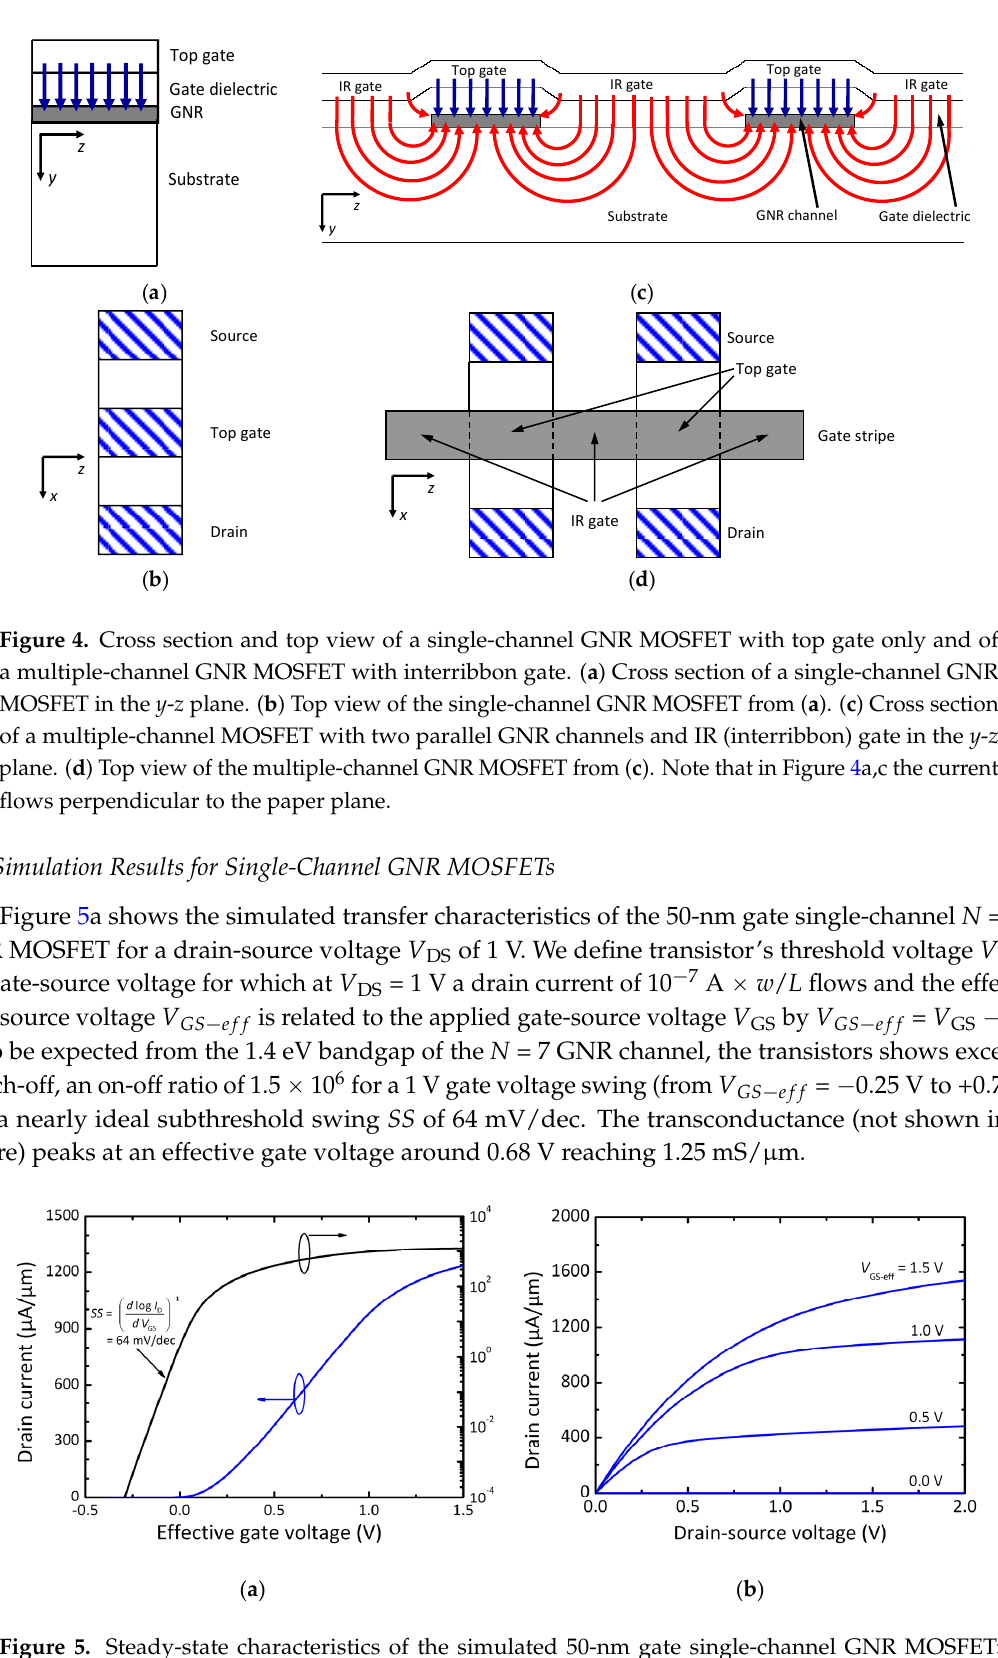
7 of 17 Figure 3. Cross-section (in the x - y plane) of the simulated graphene nanoribbon MOSFET. 3.1. Simulated Transistor Structures The basic structure of our simulated GNR MOSFETs is shown in Figure 3 in a cross-sectional view. The current flows in the x direction, the width of the GNR extends into the z direction (not shown), and the thicknesses of the substrate, the GNR channel, and the gate dielectric extend into the y direction. The structure consists of a semi-insulating SiC substrate, of which the upper part with a thickness of 1 µm is taken into account in the simulation. On top of the substrate, an epitaxial GNR channel consisting of a N = 7 ac GNR with a thickness of 0.35 nm is located. The GNR is assumed to possess ideal ohmic source and drain contacts at its left and right ends and the top-gate dielectric is formed by a 6.4 nm thick HfO 2 layer with a relative dielectric constant 25. This corresponds to an equivalent oxide thickness EOT of 1 nm. The gate has a length L of 50 nm and a work function equal to the electron affinity of the GNR, and the source-gate